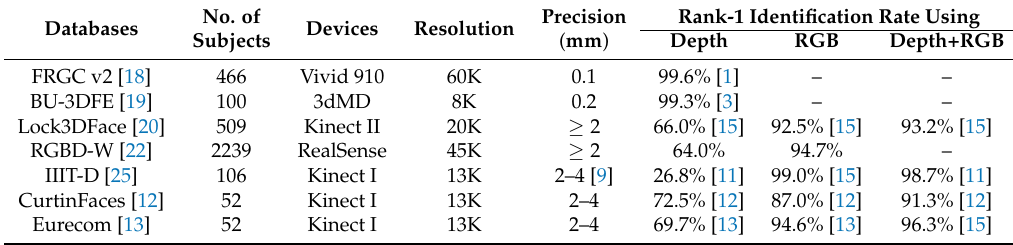
Table 1. Benchmark databases and state-of-the-art recognition accuracy on them when using depth images only, RGB images only, or both depth and RGB